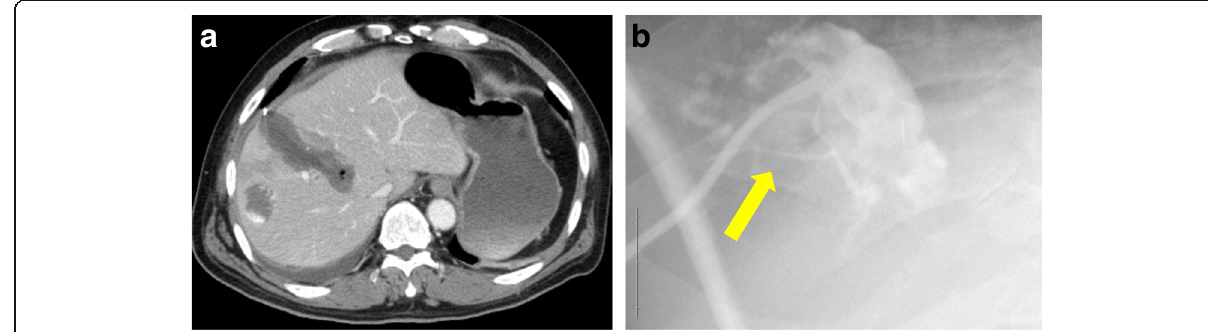
Fig. 2 On postoperative day 19, abdominal computed tomography showed the fluid at the liver cut surface ( a ). Cholangiography via the c-tube did not detect the anterior branch of the bile duct (arrows) and does not communicate with the abdominal cavity ( b )